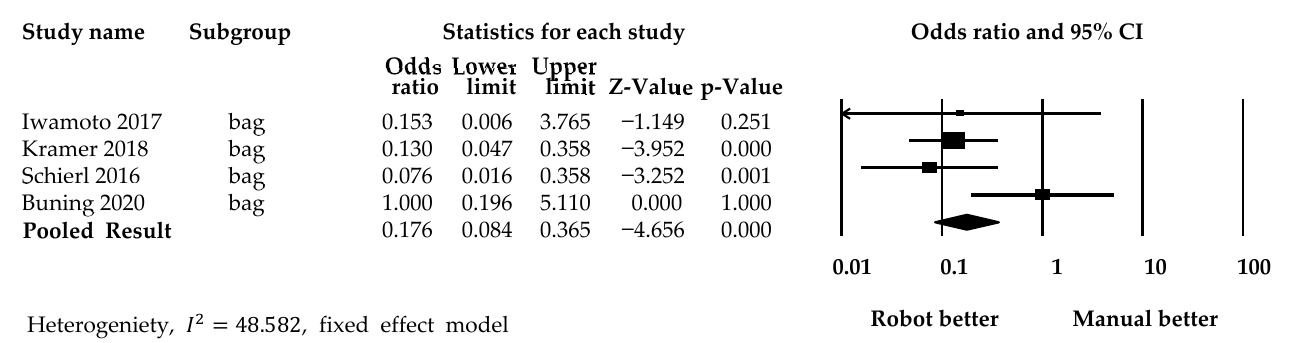
Figure 3. Forest plots showing the rate of contamination on infusion bags